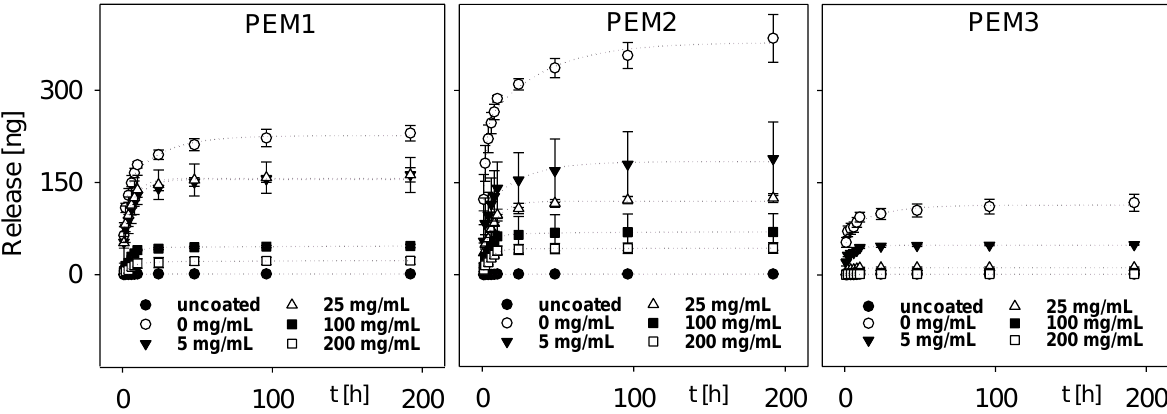
Figure 2. Release kinetics of the three coatings in dependence of the degree of cross-linking, dotted lines are to guide the eyes.